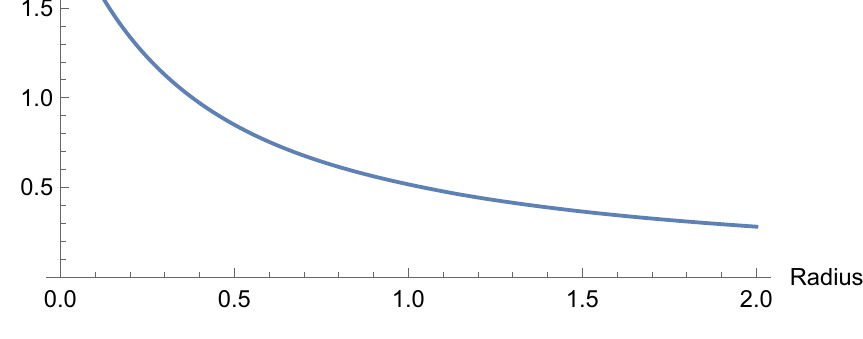
Fig. 12 Pressure p versus the radial variable x